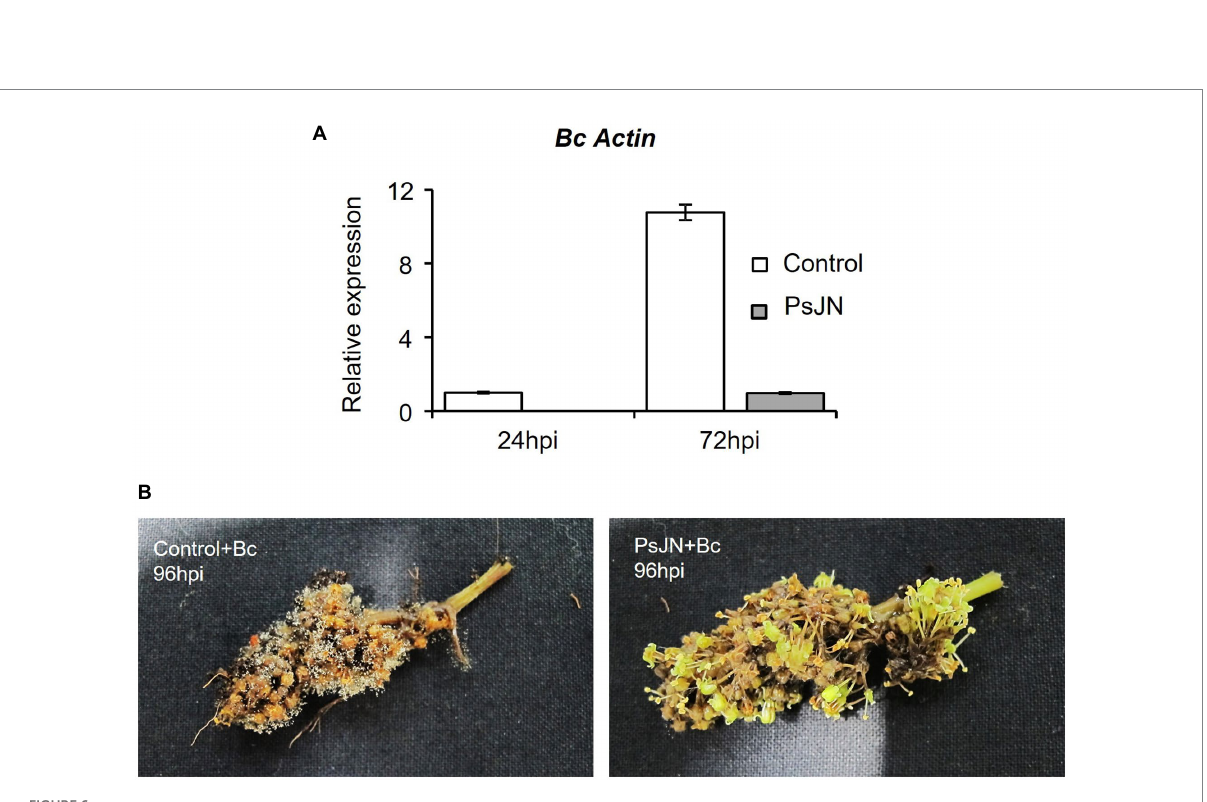
(Supplementary Figure S3), thus confirming the effectiveness of direct physical contact between the two